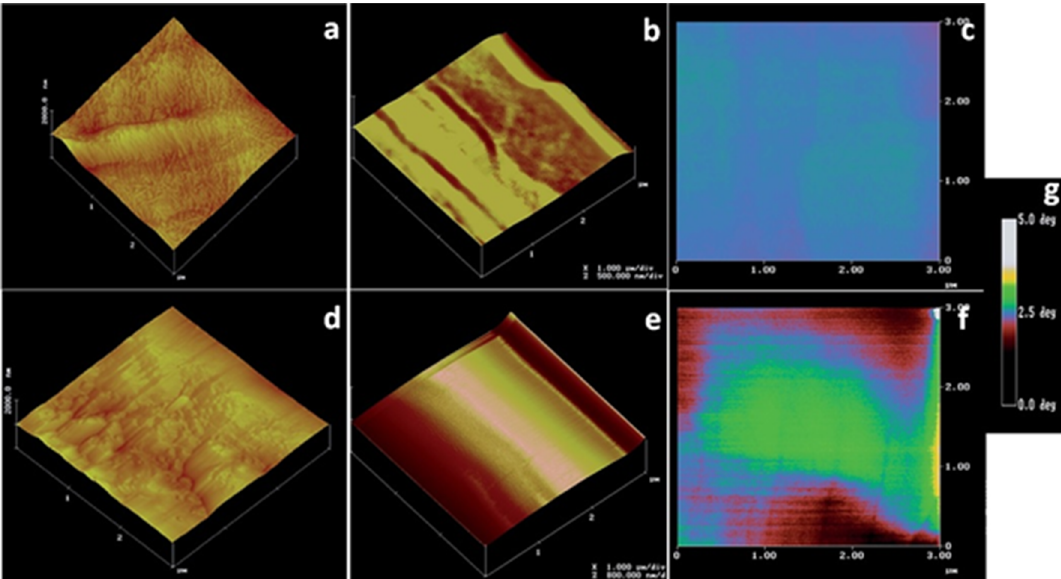
Figure 15. ( a ) Tapping mode image of cellulose isolated from switch-grass; ( b ) topographic image of switch-grass cellulose obtained in force-volume mode; ( c ) adhesion force image of switch-grass cellulose obtained in force-volume mode; ( d ) tapping mode image of extractives-free switch-grass; ( e ) topographic image of extractives-free switch-grass obtained in force-volume mode; ( f ) adhesion force image of extractives-free switch-grass obtained in force-volume mode; ( g ) a false color scheme based on the calibrations used for the depiction of the adhesion forces [222]. (Reprinted with permission from Lee et al., 2015.)